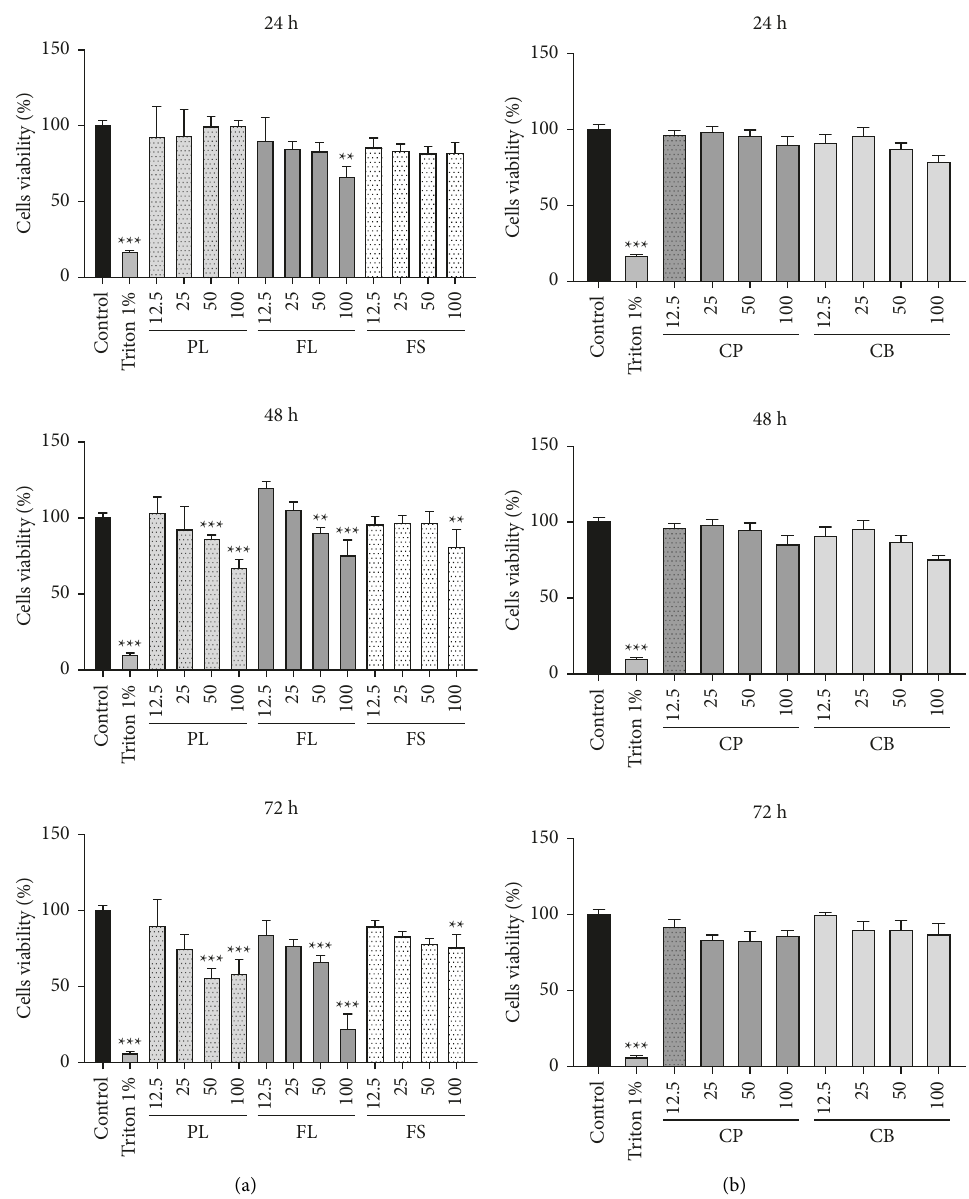
Figure 7: Effect of hydroethanol extracts (PL, FL, and FS) and various collagens (CP and CB) on the viability of fibroblasts (3T3-L1) after 24h, 48h, and 72h incubation. PL: P. lentiscus leaf extract; FL: C. officinalis leaf extract; FS: C. officinalis flower extract; CP: fish collagen; CB: bovine collagen. 3T3-L1 cells were treated with different concentrations of collagens and hydroethanol extracts (12.5 and 25 μ g/mL) for three successive times of incubation 24, 48, and 72 hours, and cell viability are assessed by MTTassay. Cell viability is assessed by the MTTtest. The values presented are means standard deviation and are representative of three independent ±